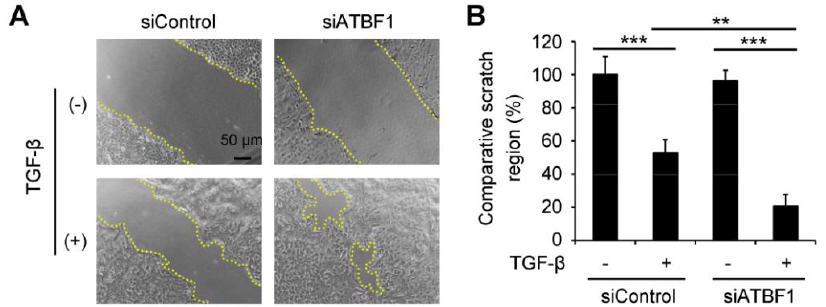
Figure 3. Knockdown of ATBF1 by siRNA promoted cell migration under activation of TGF- β . Wound healing assay was used to assess the cell migration. Cells were transfected with siControl or siATBF1 at 25 nM. ( A ) Morphology of cells with or without TGF- β treatment was imaged under a phase contrast microscope. Yellow dotted line showed the edge of the scratch. ( B ) Scratch region was measured by ImageJ software. Comparative scratch region was defined as the scratch region in each group divided by the scratch region in the control group. ** p < 0.01; *** p < 0.001. Triplicates were performed for each group.